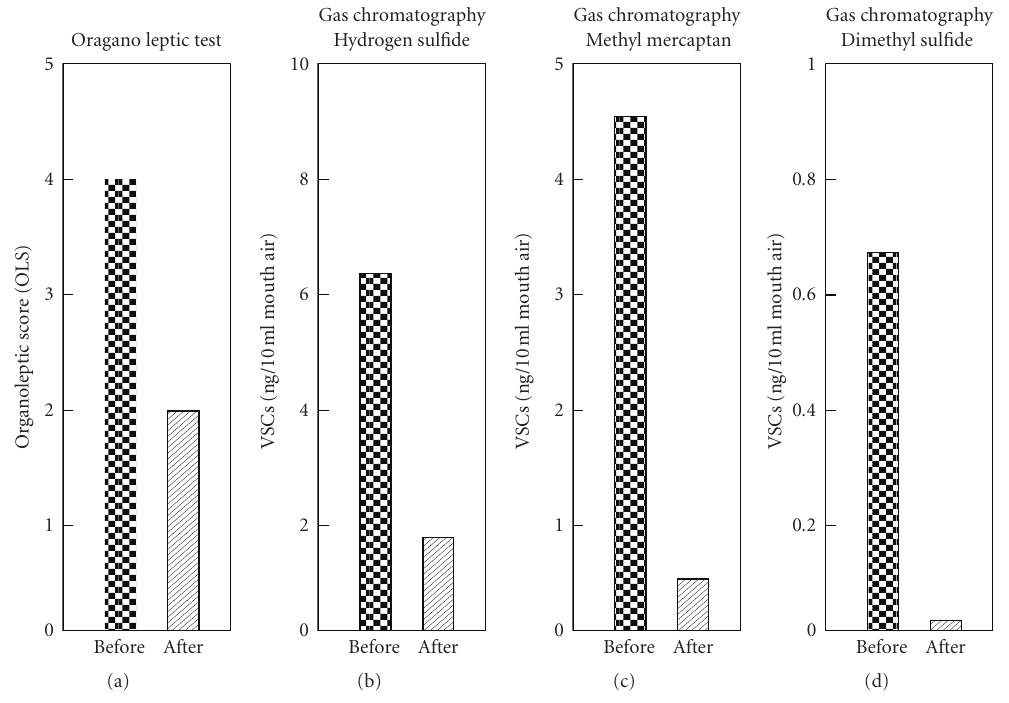
Figure 4: Comparison of breath odor measurements before and after